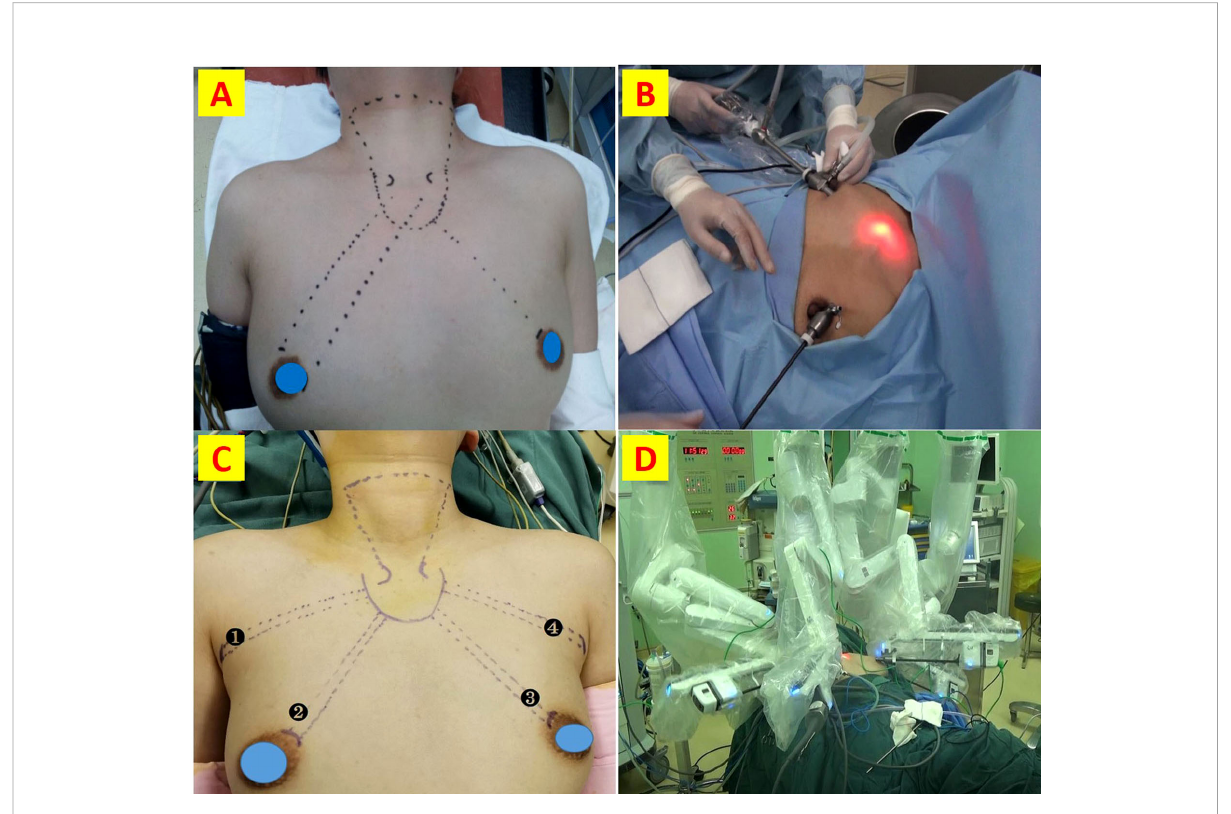
FIGURE 1 Detailed procedures for ET-BAA and RT-BABA. (A) Surgical incision and approach for ET; (B) port insertion for the bilateral areola approach; (C) Surgical incision and approach for RT; (D) robotic arm placement and surgical